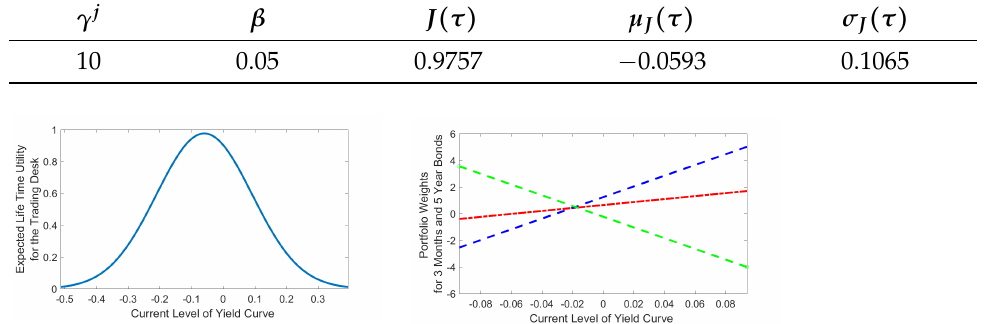
Figure 4. The Expected Lifetime Utility of the trading desk manager (32) and PortfolioWeights (33). For X > ¯ X , mean reversion (4) implies that the trading desk manager expects the level of the yield curve to fall, and hence longer duration bonds would lead to a larger capital gain. As a result, the trading desk is long five year bonds (blue dashed line) and short three month bonds (green short-dashed line) for a high expected level of the yield curve, X 1 > ¯ X 1 = − 0.0177. If the random change in the future yield factors is positive, Y τ > 0, then the trading desk would suffer a large capital loss. The trading desk’s position is reversed for lower levels of the yield curve, X 1 < ¯ X 1 , since mean reversion implies that the trading desk expects the level of the yield curve to move back to its stationary value by (4). If the random change in future yield factors is negative, then the trading desk would suffer a capital loss.